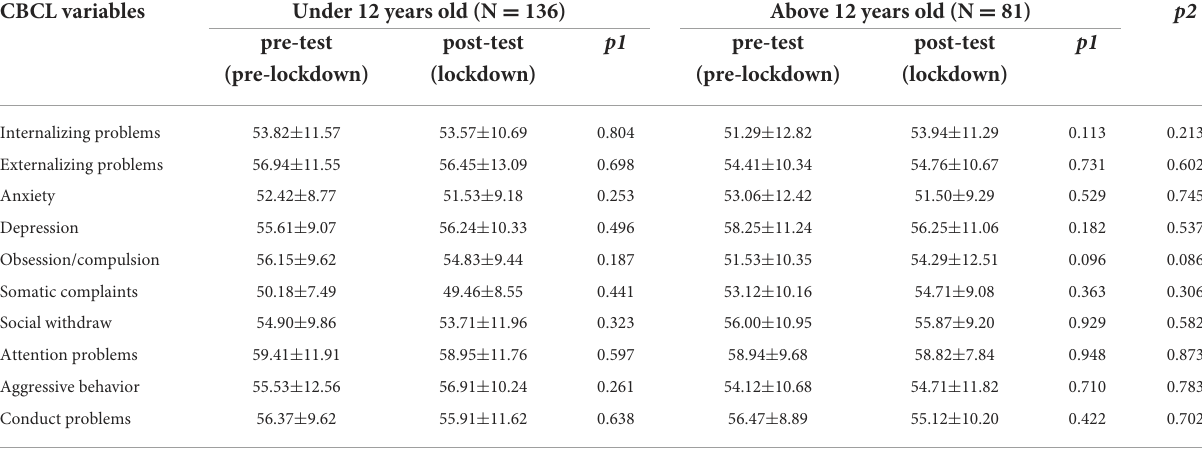
TABLE 2C Comparison of CBCL of different age groups during the lockdown and pre-lockdown periods. CBCL